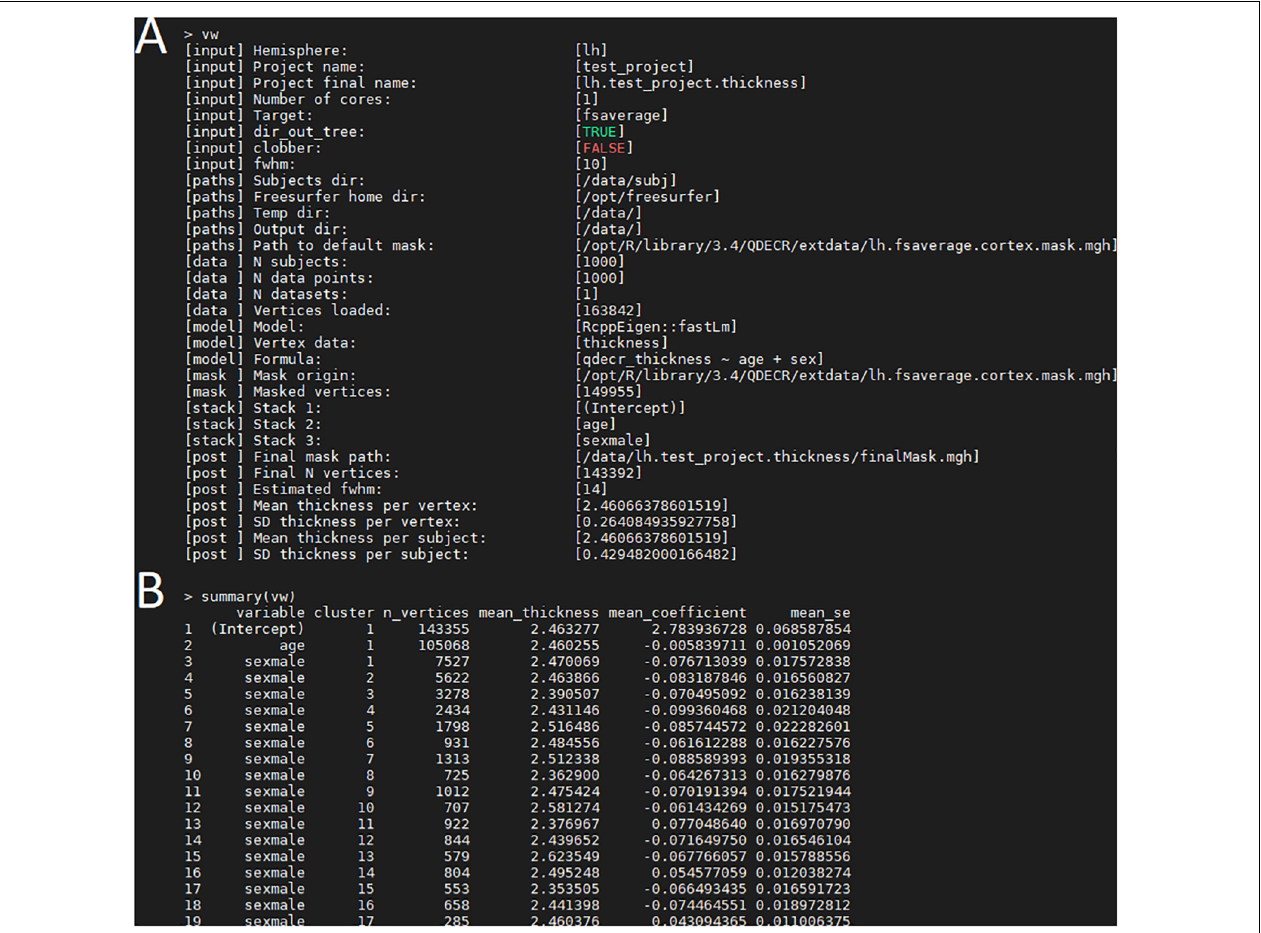
FIGURE 2 | Examination of the QDECR analysis on the association of age and cortical thickness in a subset of the UK Biobank. (A) The “print” function returns the key information of the analyzed project, including the input arguments, the included formula, the size of the dataset and the number of included vertices. (B) An example of output from the “summary” function. Each row represents a statistically significant